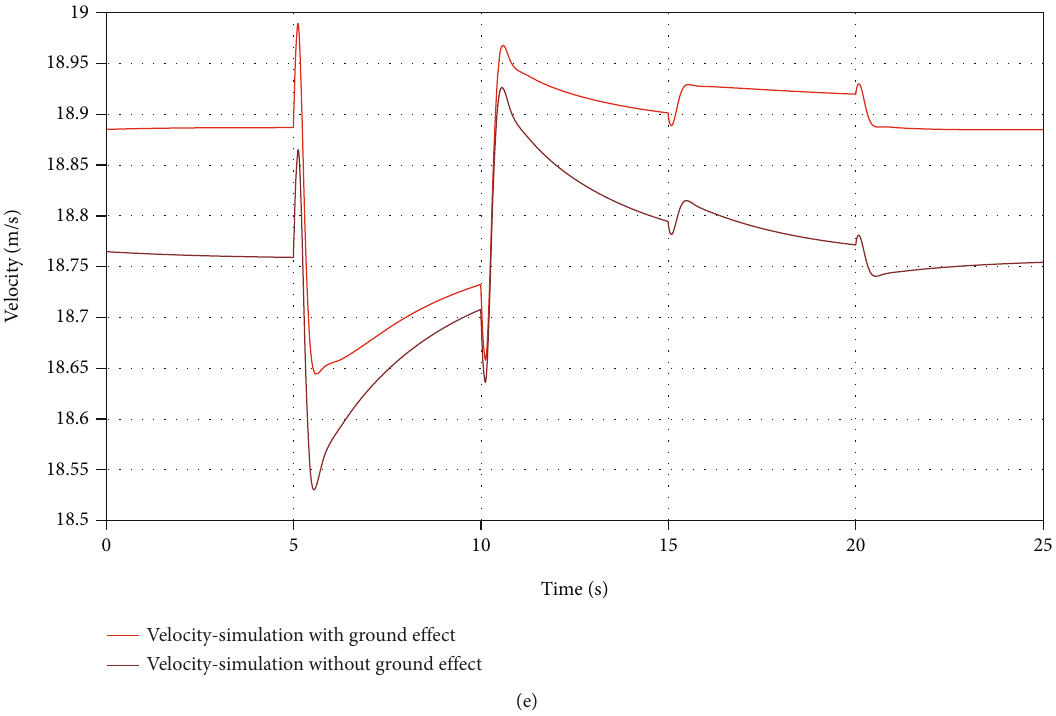
Figure 6: Comparison of simulation results with and without ground e ff ect. (a) Comparison of altitude change. (b) Comparison of oscillations in pitch angle. (c) Comparison of thrust. (d) Comparison of degrees of fl aps. (e) Comparison of